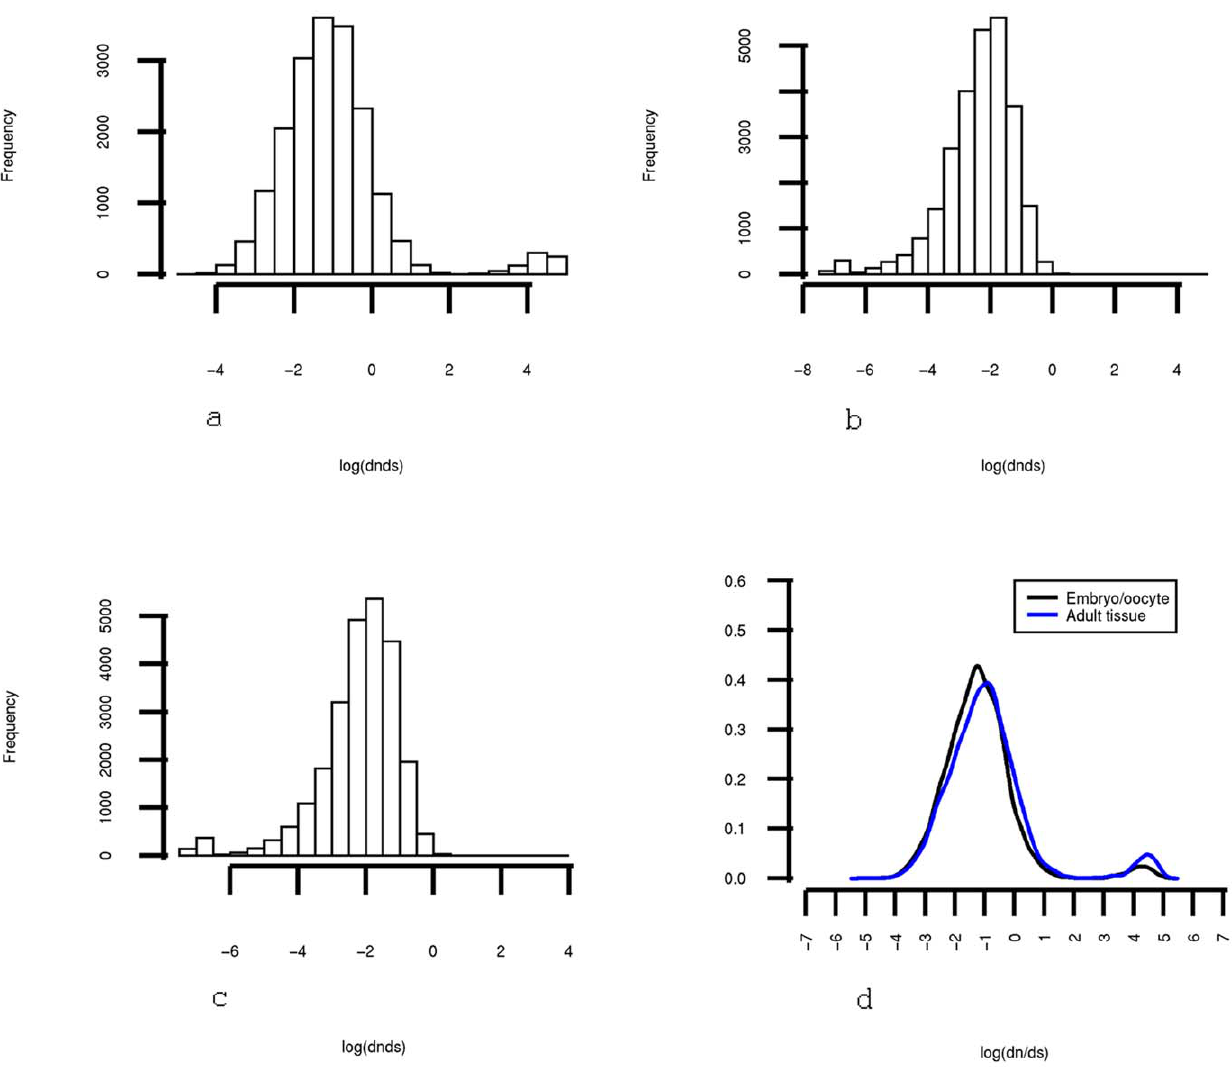
Figure 3. Dn/ds distribution for chimp (a), dog (b) and mice (c) for the probe sets interrogated by the HG-U133plus2 arrays. Positive selection signature can be observed in the chimp on the right side of the histogram. (d) Comparison of dn/ds for the chimp between embryo/oocyte specific and adult tissue specific probes. Testing the difference between the distributions with a nonparametric (Mann-Whitney) test yields a median shift of about 15% with a two-tailed significance p-value 10e 2 16.